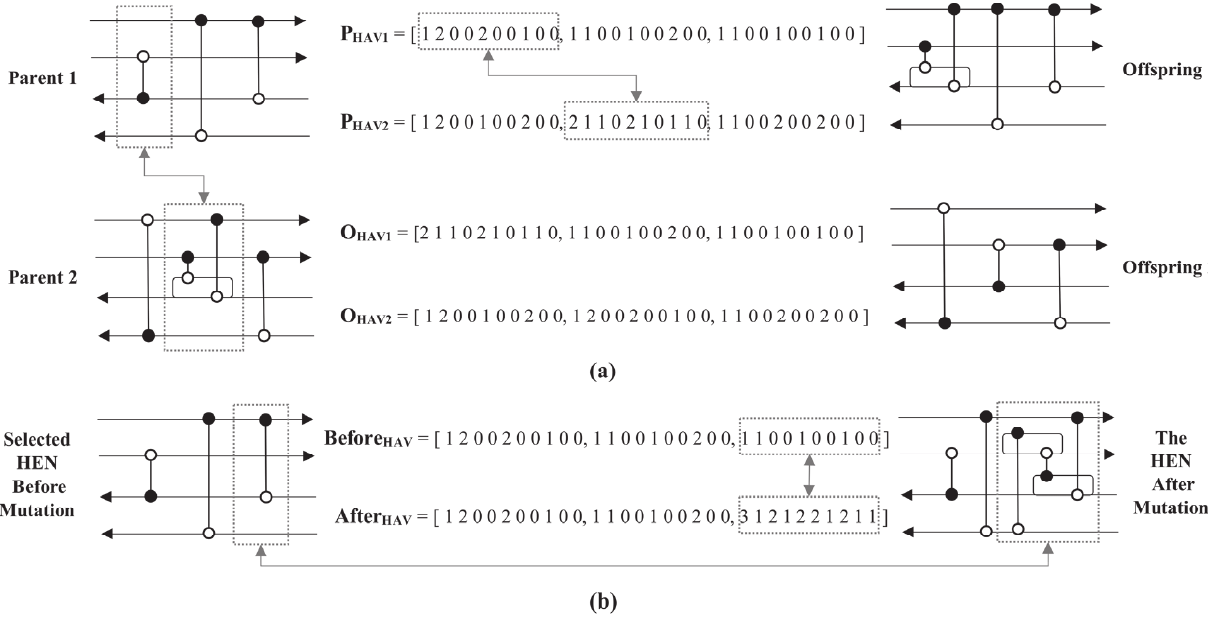
Figure 3 Fig. 3 (a) – Performance of the crossover operator for single point mode, and (b) mutation